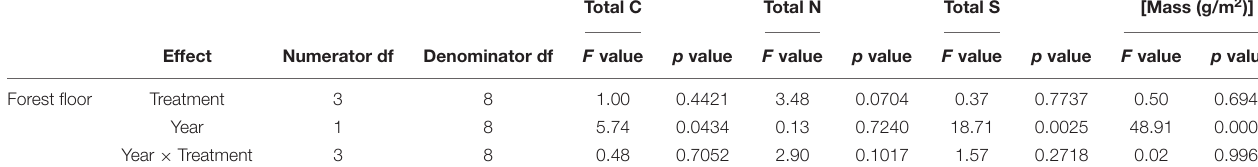
TABLE 3 | ANOVA summary table for forest floor and mineral soil chemical properties (1995/1996–2020).